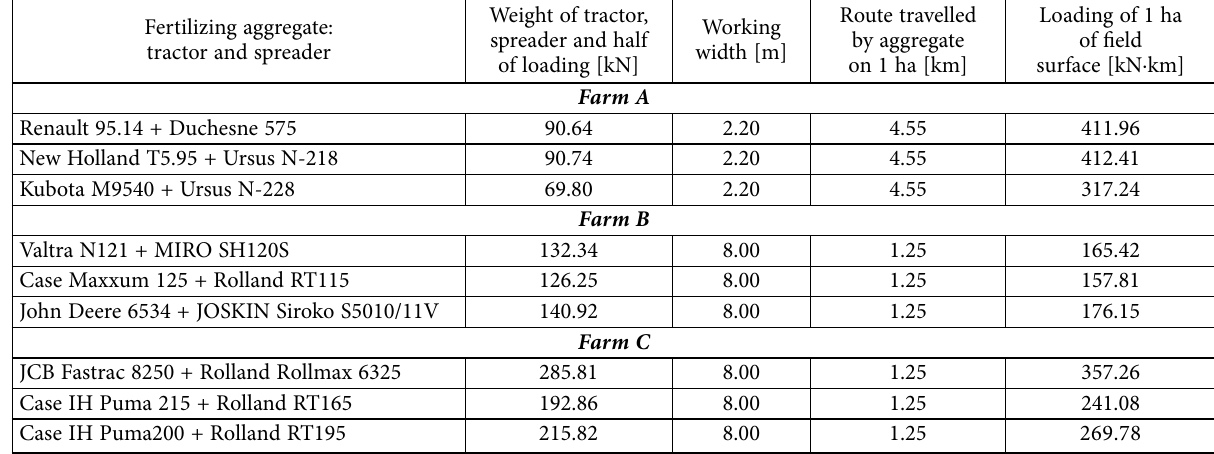
Table 7. Values of the unit pressure in trace of aggregate driving wheels Weight [kN] Farm symbol